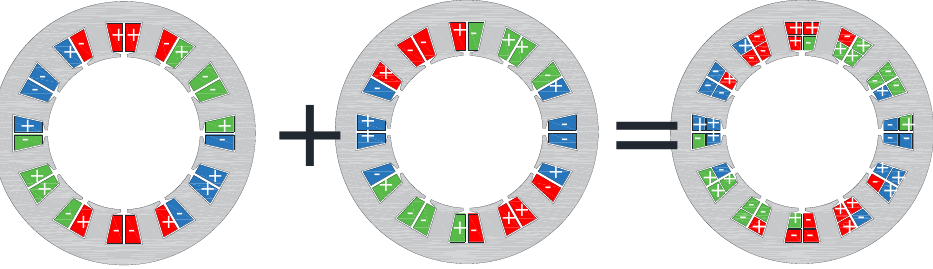
Figure 1. Principle of four-layer winding definition.